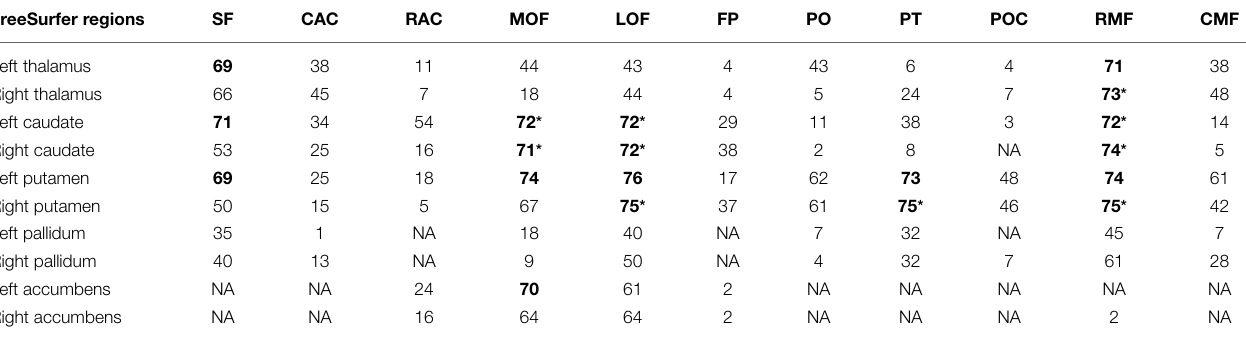
TABLE 3 | Number of subjects (maximum is 76) for which structural connections could be identified, according to the criteria described in the text, between seed ROIs representing subcortical nuclei (left column) and 11 target ROIs in frontal white matter areas (top row): superior frontal (SF), anterior cingulate [caudal anterior cingulate (CAC), rostral anterior cingulate (RAC)], orbitofrontal [lateral orbitofrontal (LOF), medial orbitofrontal (MOF)], frontal pole (FP), inferior frontal [pars orbitalis (PO), pars trinagularis (PT), pars opercularis (POC)], and the middle frontal [caudal middle (CMF) and rostral middle (RMF)].